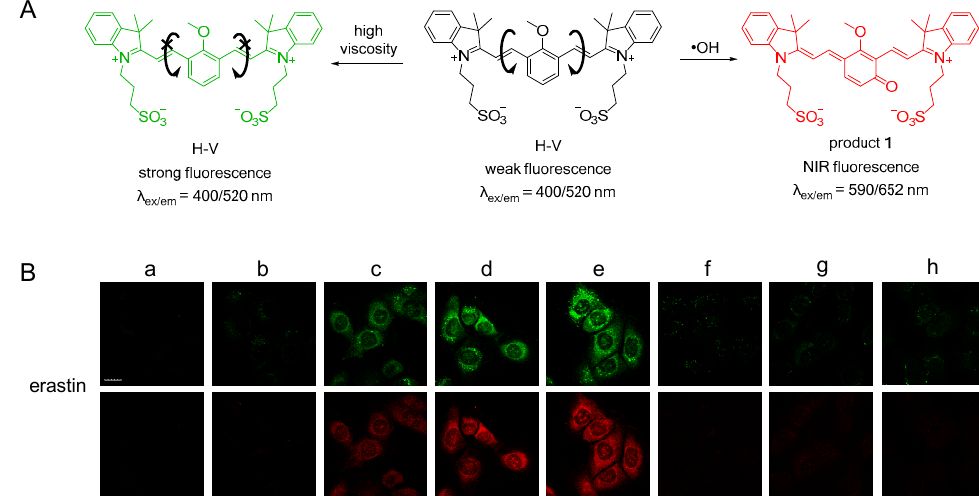
Figure 8. The •OH and viscosity dual − functional fluorescence probe H − V and its application in imaging of changes in •OH level and cytoplasmic viscosity during erastin − initiated ferroptosis of HT − 1080 cells. ( A ) Response mechanism of H − V to •OH and viscosity. ( B ) Fluorescence images of HT − 1080 cells under different conditions. ( a ) Cells only. ( b – e ) Cells pretreated with erastin for ( b ) 0 h, ( c ) 4 h, ( d ) 6 h, or ( e ) 8 h and then incubated with H − V for imaging. ( f – h ) Cells pretreated with erastin in the presence of ferroptosis inhibitor ( f ) DFO, ( g ) Fer − 1, or ( h ) Lip − 1 for 8 h and then incubated H − V for imaging. Green channel and red channel reflected the changes in cytoplasmic viscosity and •OH level, respectively. Reprinted/adapted with permission from Ref. [51]. Copyright 2019, American Chemical Society.